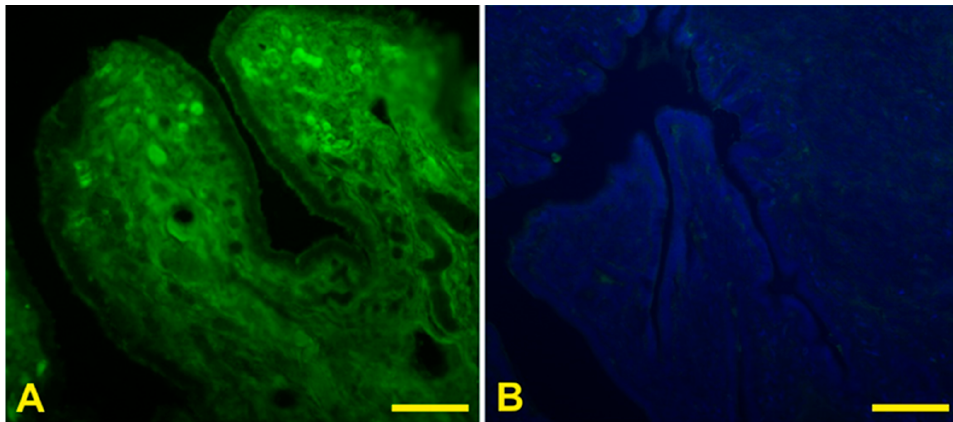
Figure 2. Representative effect of the hapten sugar on the lectin staining. Ampulla from preovulatory baboon Papio hamadryas incubated with SNA ( A ) and with SNA in presence of its hapten sugar ( B ). Scale bars: ( A , B ) = 100 μ m.